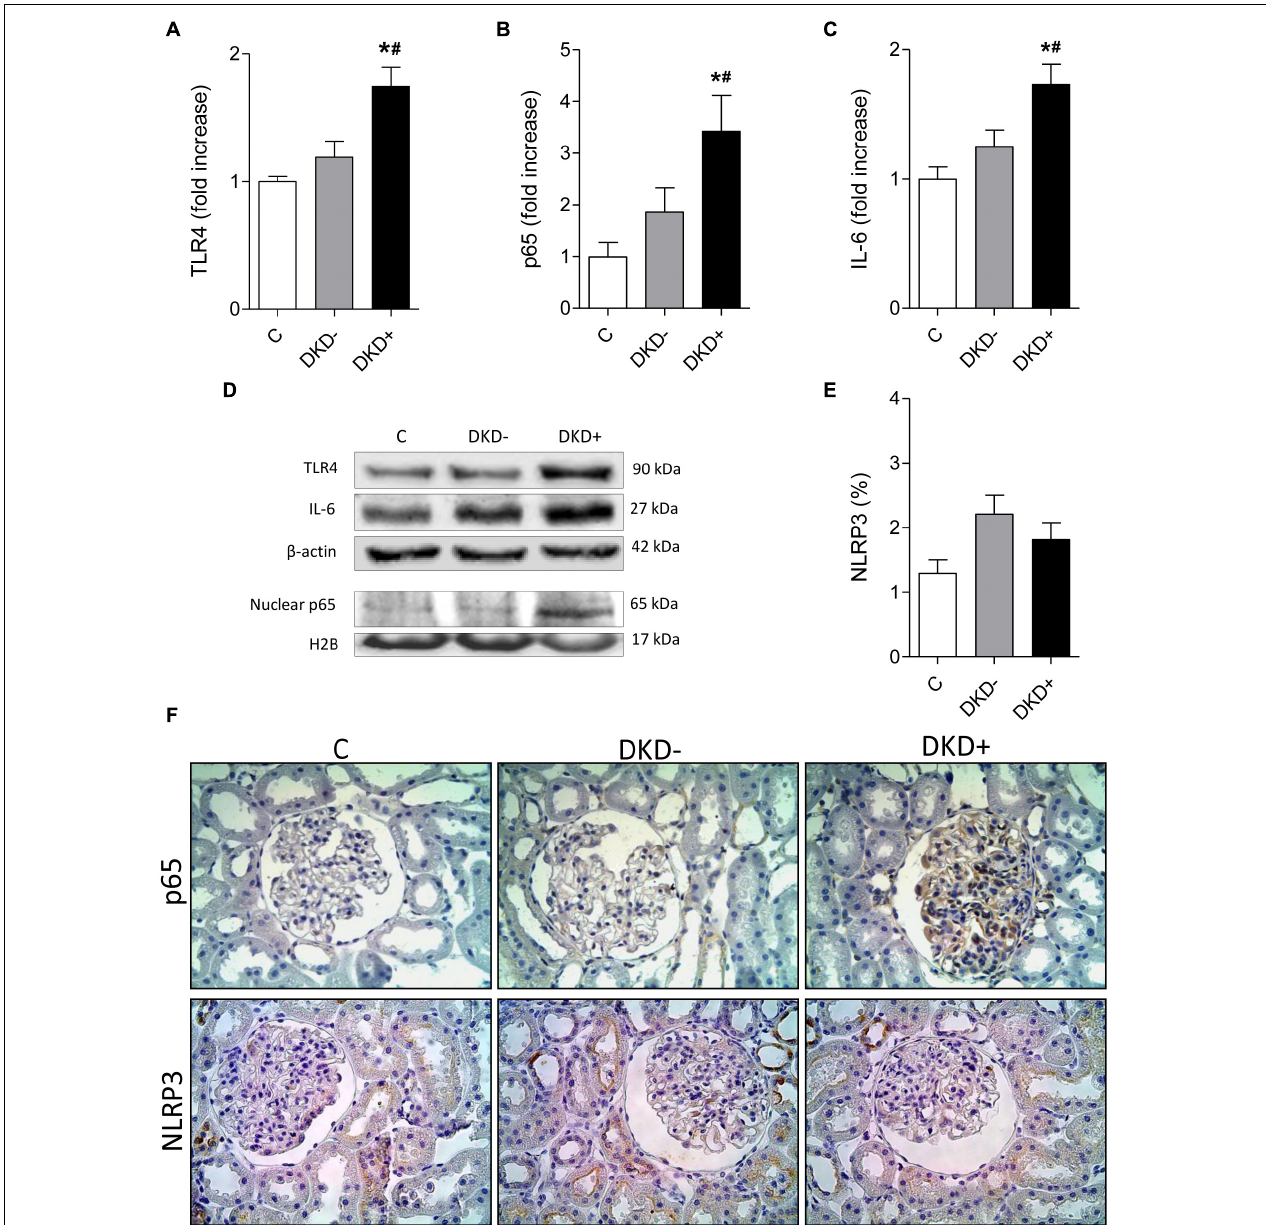
FIGURE 3 | Diabetic rats with (DKD+ group, n = 10) or without (DKD– group, n = 10) significant glomerular injury were analyzed 12 months after streptozotocin injection. Twelve non-diabetic age-matched rats were taken as controls (C group). The renal cortical contents of (A) Toll-like receptor 4 (TLR4), (B) nuclear fraction of phosphorylated NF- κ B component (p65), and (C) interleukin 6 (IL-6), were quantified using (D) western blot analysis. Panel (E) shows the percent glomerular area staining for NLRP3 (%) quantified by immunohistochemistry. (F) Representative microphotographs show the presence of p65-positive or NLRP3-positive immunostaining (brown) in glomeruli ( × 400). No difference in NLRP3 positivity was observed between groups DKD– (non-progressors) and DKD+ (progressors). Results expressed as means ± SE. * p < 0.05 vs. C, # p < 0.05 vs.